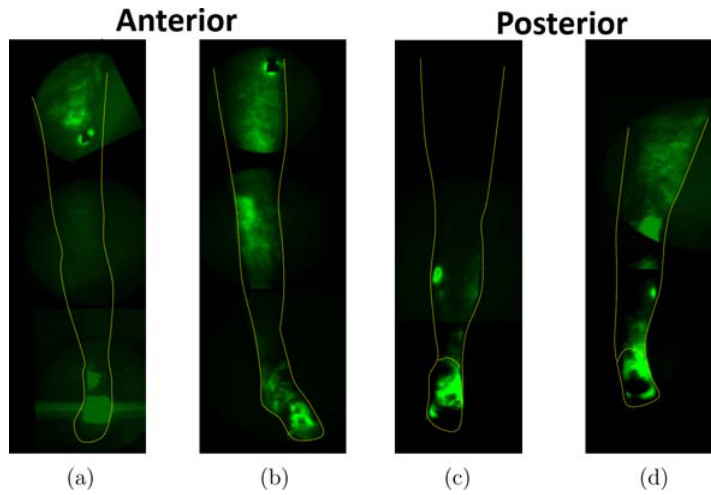
Note : Full-leg images are montages of smaller regional images. Fig. 8. Fluorescent dye/lymph distribution in subject 2's left (LE-a®ected) leg before and after PCT. (a) NIRFLI image of anterior left leg before PCT, (b) anterior left leg after PCT, (c) posterior left leg before PCT, (d) posterior left leg after